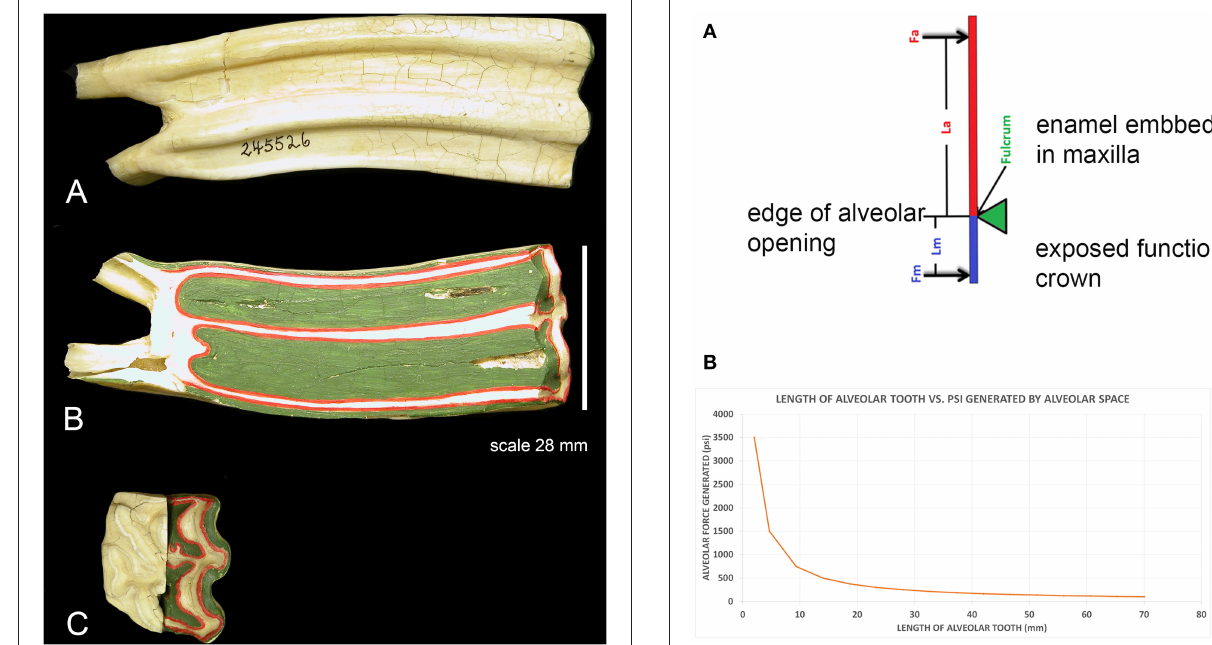
FIGURE 2 | An upper second molar of Equus caballus AMNH 245526 sectioned longitudinally and hand-painted. Colors: red is enamel, green cementum, white is dentine. The section is through the central cavities which are filled with cementum. The cementum is notably thick, and it surrounds the entire tooth. The enamel is thin. (A) The external aspect there the tooth is covered by cementum including the roots where it is thinner coating and hard to observe. (B) The inner aspect; note that the majority of the section is composed of cementum. The enamel is thin. (C) Occlusal view; half of the tooth is painted, and the other half is natural. ( Figure 2 ). In order to calculate enamel thickness and cementum we used Image J (Fiji) that quantified the tissues in photographs as pixels and calculated the square mm (specimen of Figure 2 ).